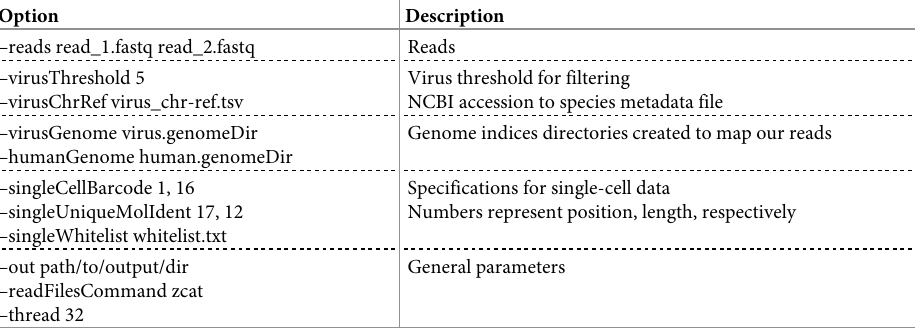
Table 1. Venus’s detection module